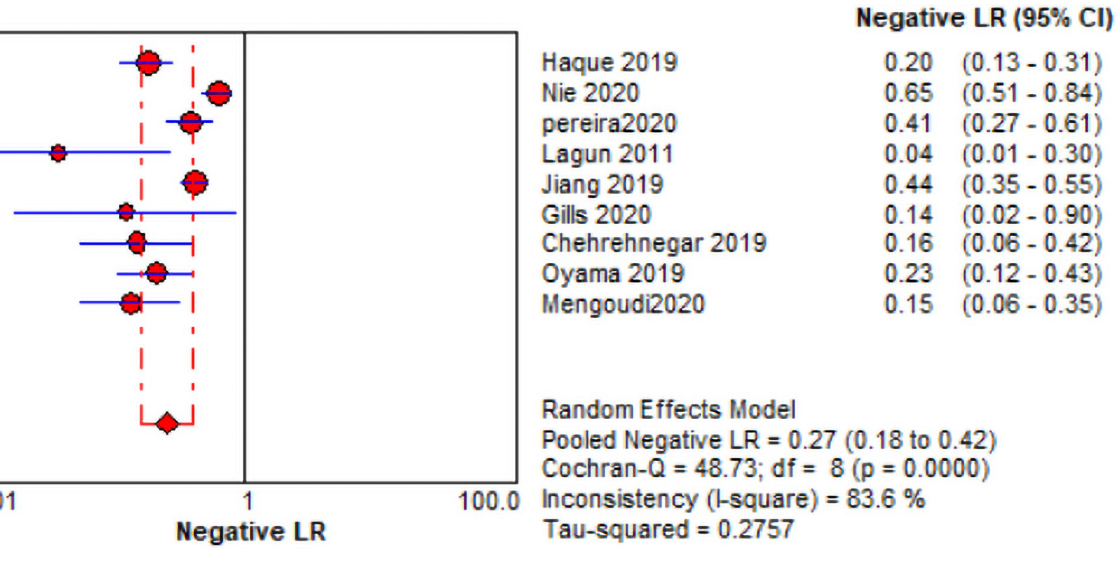
Fig 7. Forest map of